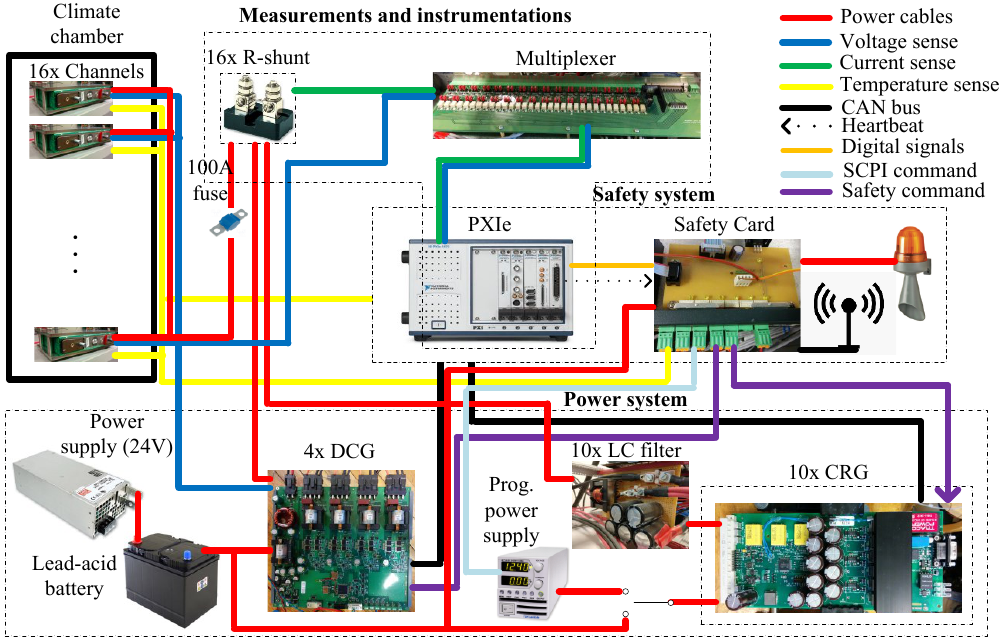
Figure 1. Hardware configuration of the experimental